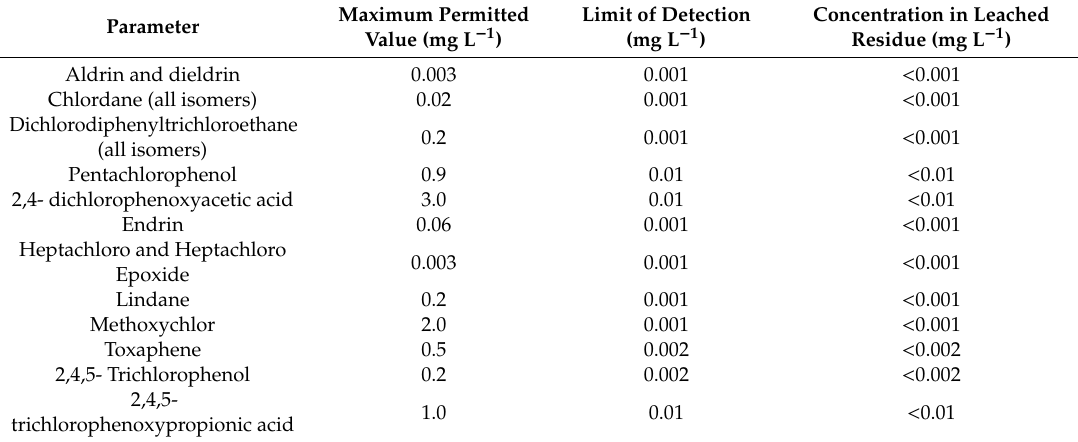
Table 2. Classification of leached residues for organic parameters (pesticide), according to the United States Environmental Protection Agency—USEPA [10]; maximum permitted value, limit of detection, and the concentration in the leached